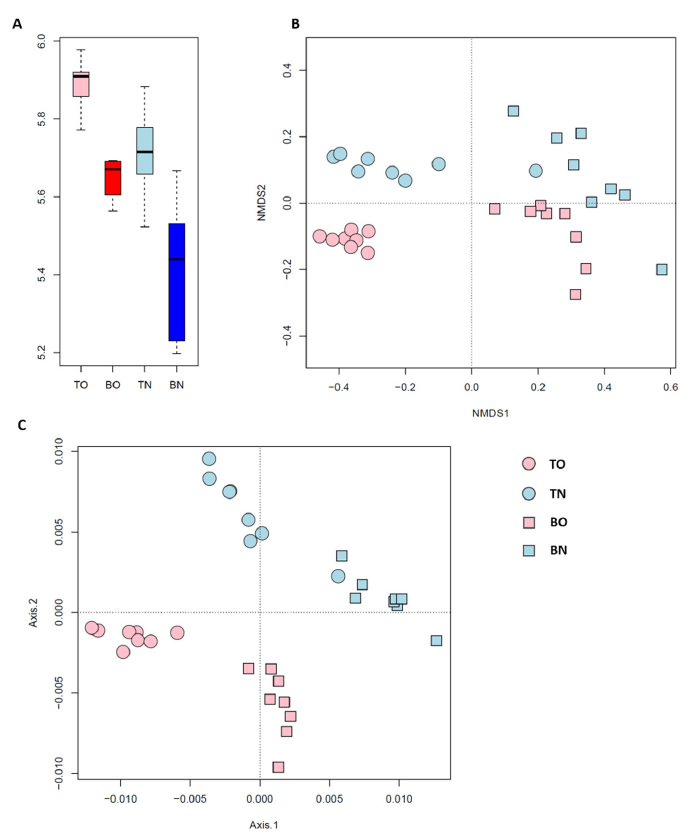
Figure 3. Diversity of benthic communities. ( A ) The α -diversity; ( B ) the non-phylogenetic β -diversity, visualized through NMDS based on Bray–Curtis distance; ( C ) the phylogenetic β -diversity, shown by PCoA. Each point in B and C represents one sample.